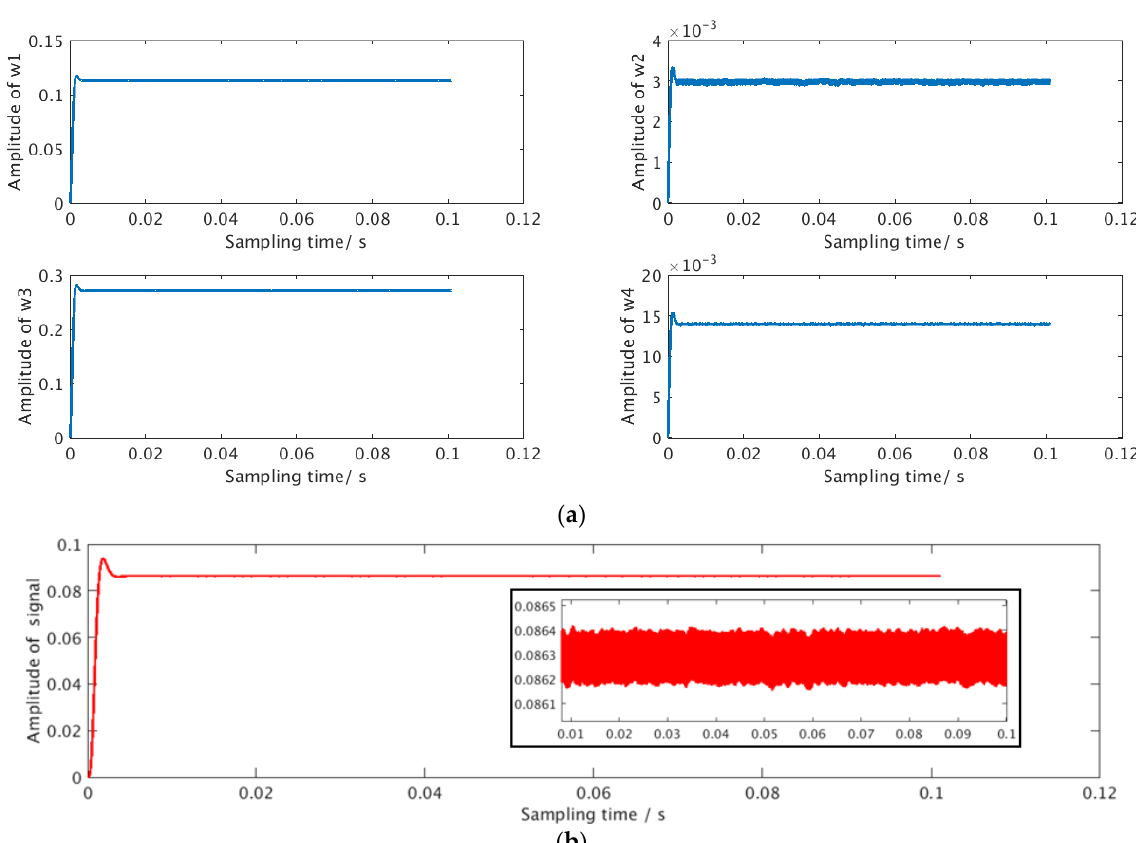
Figure 7. Simulation results for digital demodulation. ( a ) Convergence process of reference signal amplitude components; ( b ) the simulated sensor signal.